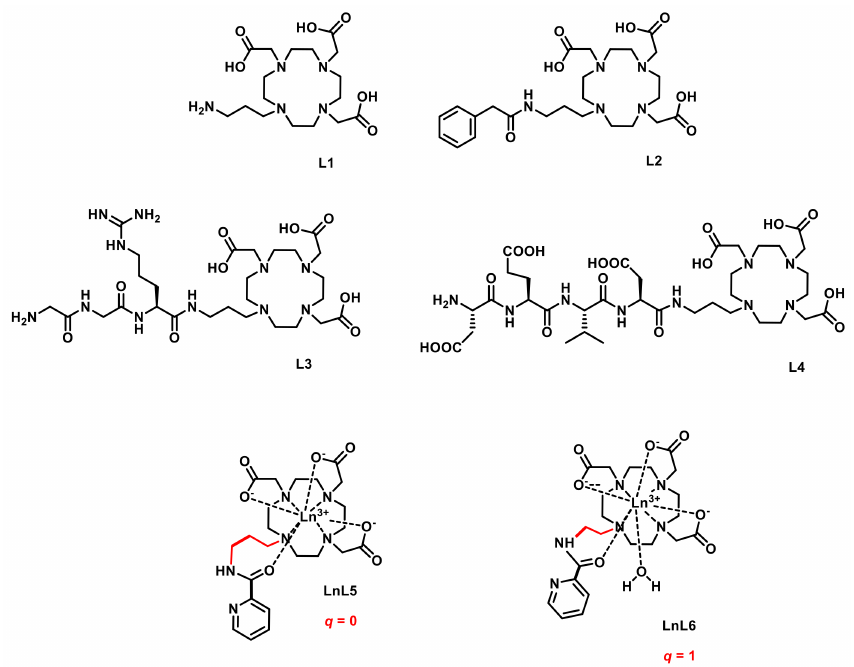
Scheme 1. Structure of the ligands L1, L2, L3 and L4, and coordination modes for the LnL5 and LnL6 complexes [27] discussed in the